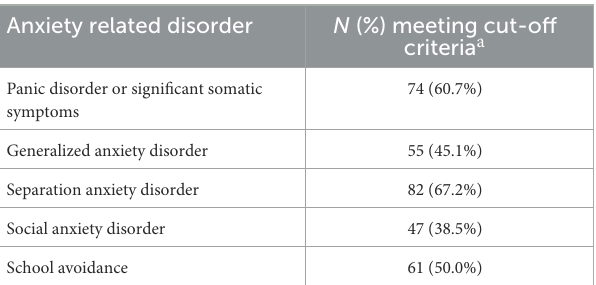
TABLE 5 Prevalence of symptoms of anxiety related disorders among farm adolescents ( N =